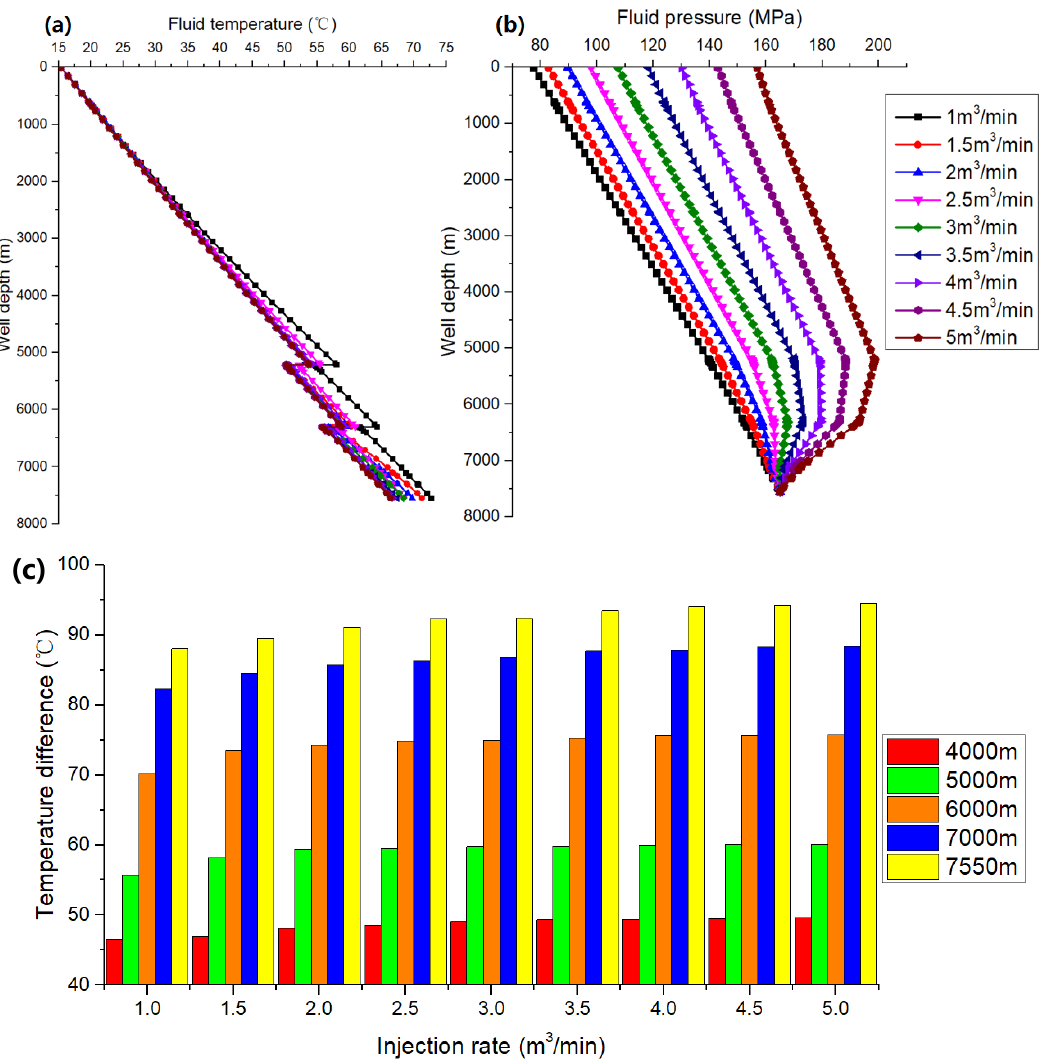
Figure 10. Fluid temperature and pressure under different injection rates vs. well depth: ( a ) temperature, ( b ) pressure, and ( c ) temperature difference. Table 2. The fitting formulas of temperature distribution in the tubing string under different injec- tion rates (temperature is defined as T, de is depth).